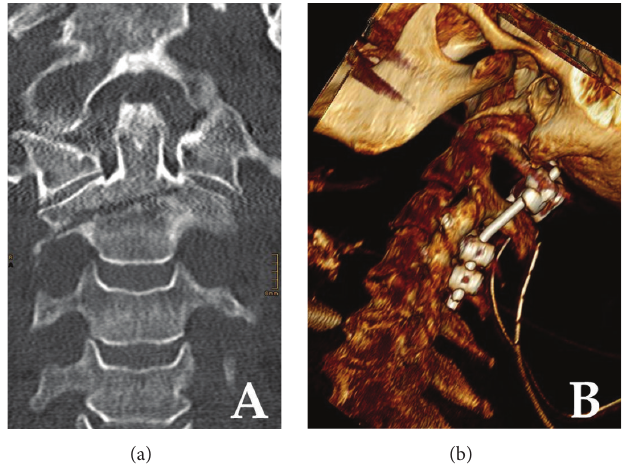
Figure 2: Cervical spine CT imaging of a 71-year-old woman. (a) Coronal plane CT imaging showing the minimally displaced oblique type axis body fracture. Note the marked similarity of the fracture pattern when compared to that shown in Figure 1(a). (b) Three-dimensional computed tomographic VRT reconstruction following C1–C3/C4 posterior fusion with a polyaxial screw-rod